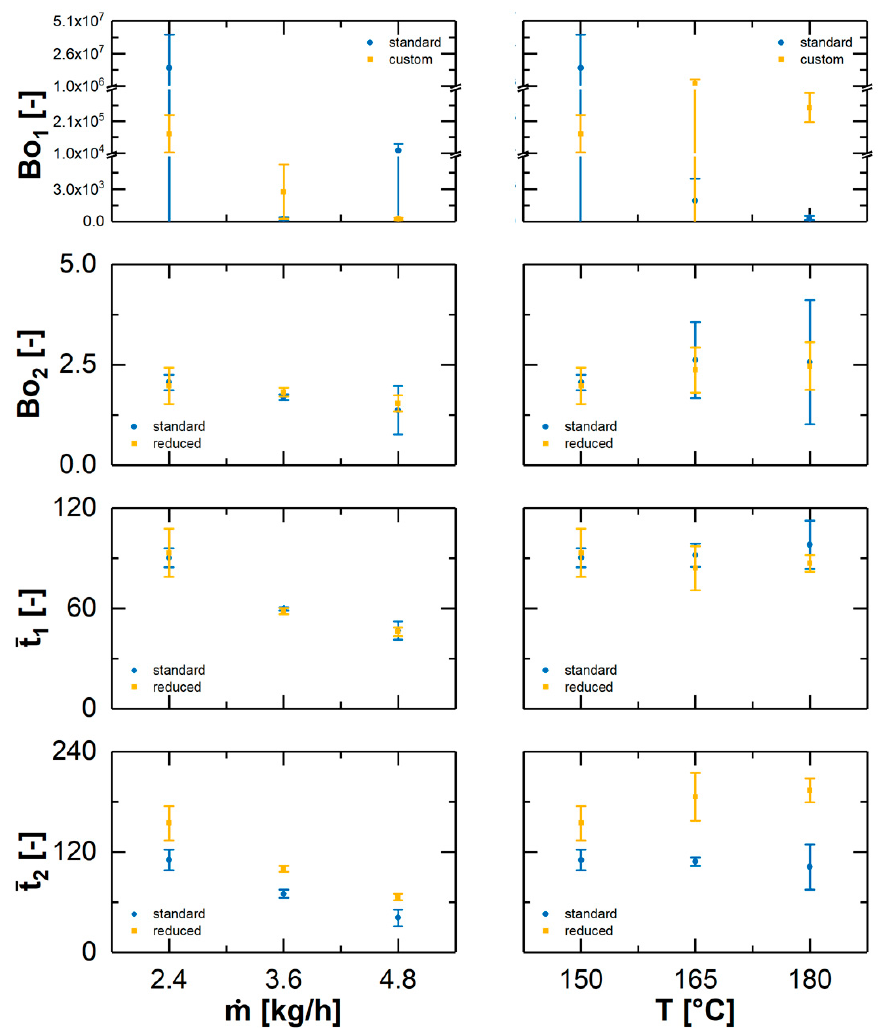
Figure 3. Obtained characteristic model parameters in comparison for a screw configuration with standard element and custom designed elements with a reduced outer diameter for an enlarged clearance. The effect of the total mass flow and of the barrel temperature profile is presented separately (av ± s, n = 3).